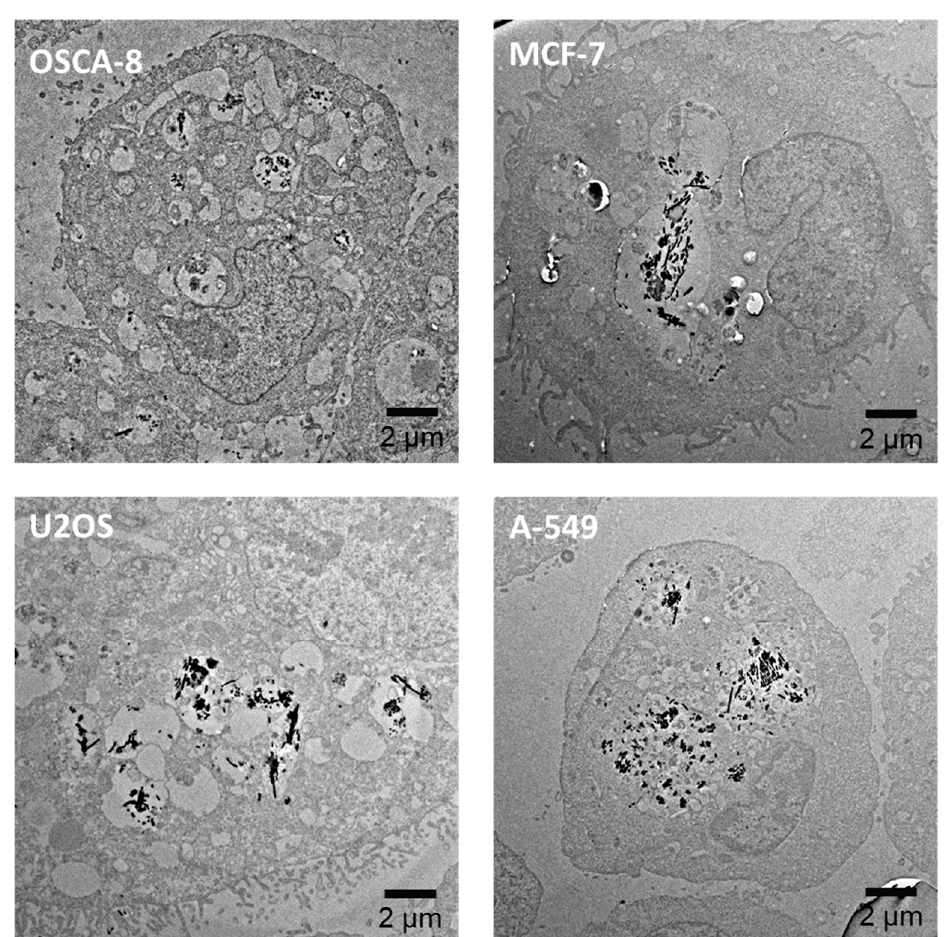
Figure 5. TEM images of Ni MNWs internalized by OSCA-8, MCF-7, U2OS, and A-549